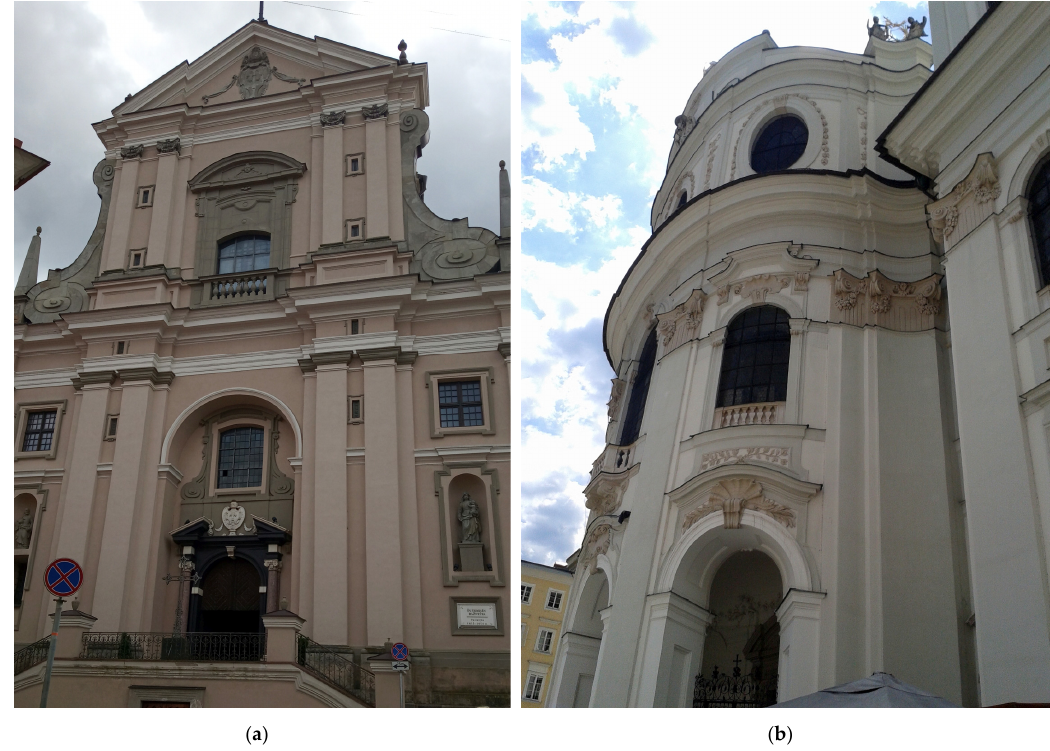
Figure 10. The architectural order with stone chapiters is distinguished by white stripes of cornices and architrave and a darker frieze: ( a ) the façade of the church of St. Teresa in Vilnius (1654); ( b ) a grey order, light background and stucco decorations—the Kollegienkirche (Collegiate Church) by J.B. Fischer von Erlach (1696–1707). Photos by author.